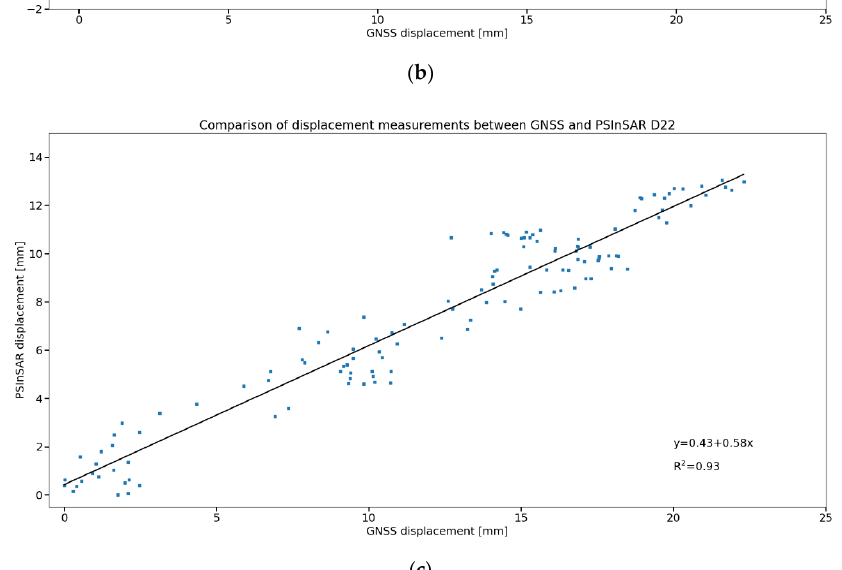
Figure A2. Comparison of displacement between GNSS and PSInSAR for track A73 ( a ), D127 ( b ), and D22 ( c ). The R 2 value is the squared correlation coefficient between compared displacement measurements, and when R 2 equals 1, the data being compared are the same. In our case, R 2 is close to 1 for tracks D22 and D124, and for track A73 R 2 = 0.